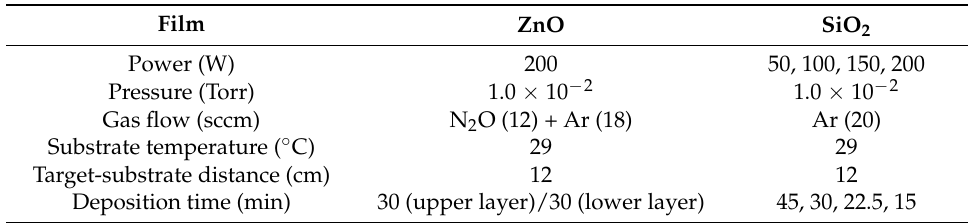
Table 4. Deposition conditions of both ZnO and SiO 2 thin films used to fabricate the ZSZ ‐ MGs in Figure 10.